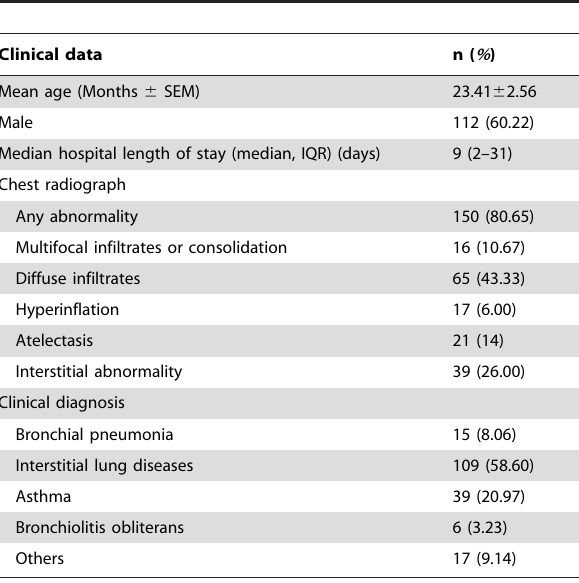
Table 1. Demographic and clinical characteristics of patients (n=186).